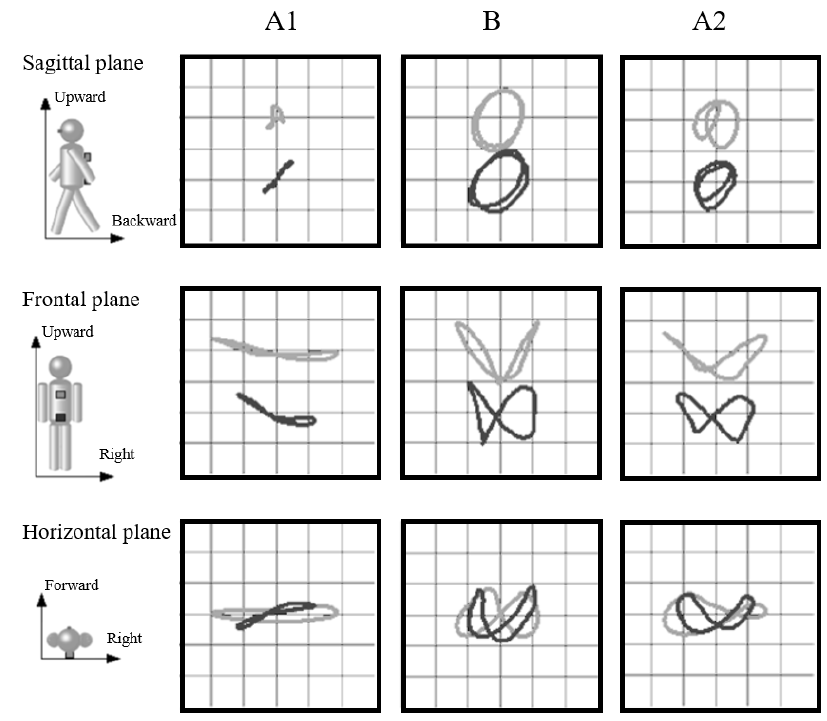
Figure 5. The trajectory of the thoracic and pelvic displacements in the sagittal, frontal, and horizontal planes at the A1–B–A2 phases.